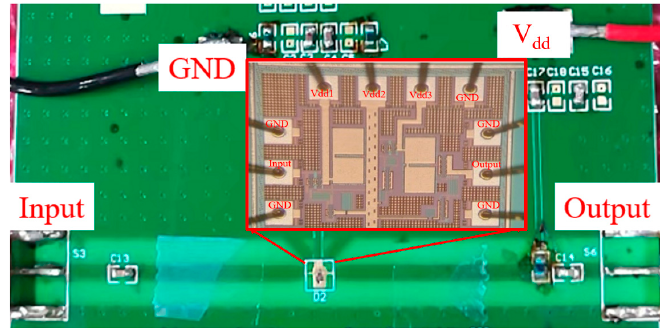
Figure 1. The chip microphotograph of the CMOS PA.